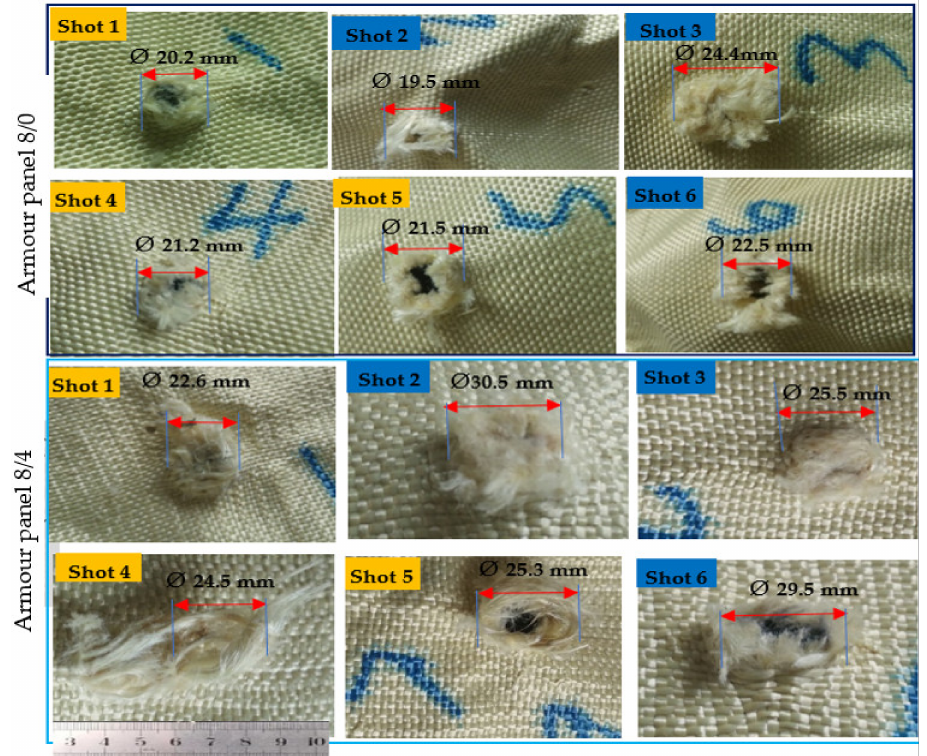
Figure 7. Typical impact surface damage and its diameter of armour panels made of fabric variants 8/0 and 8/4 at moulded (shot 1, 4 and 5) and nonmoulded areas (shot 2, 3 and